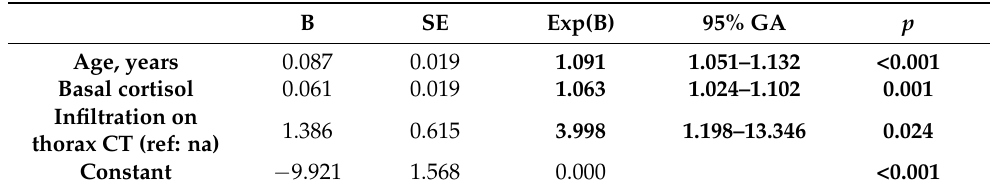
Table 3. Multiple logistic regression analysis to determine risk factors affecting ICU admission in COVID-19